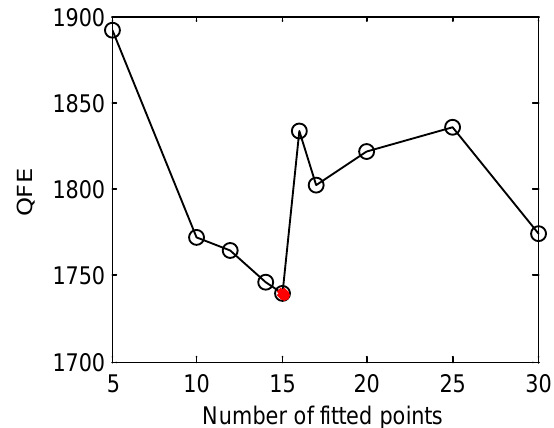
Figure 7. Fault diagnosis of fault 7 with grey model-predicted initial values.